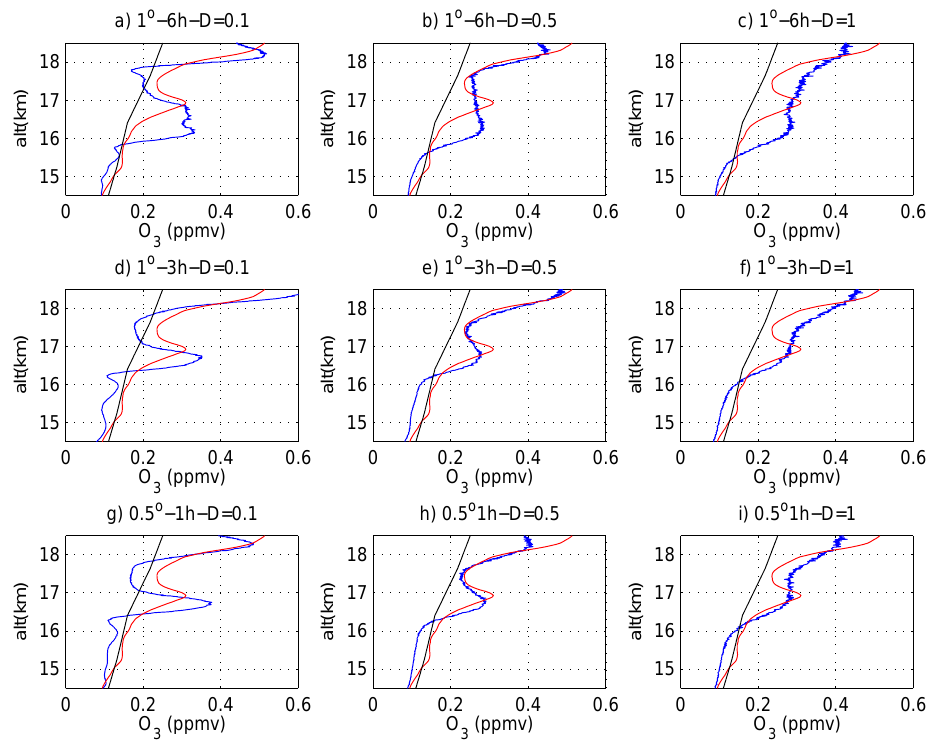
Fig. 1. Red, black and blue lines represent respectively the measured O 3 profile, the profile at the time and location of the measurement interpolated directly from REPROBUS and the profile provided by a diffusive reconstruction based on 192h back trajectories. Each row corresponds to a given temporal and space resolution for the advecting winds and each column to a given diffusivity value D in m 2 s − 1 . First row: 6 hours – 1 ◦ × 1 ◦ . Second row: 3 hours – 1 ◦ × 1 ◦ . Third row: 1 hour – 0.5 ◦ × 0.5 ◦ . First column: D =0.1 m 2 s − 1 . Second column: D =0.5 m 2 s − 1 . Third column: D =1 m 2 s − 1 . The horizontal axis represents ozone mixing ratio (ppmv) and the vertical axis represents altitude in kilometres.